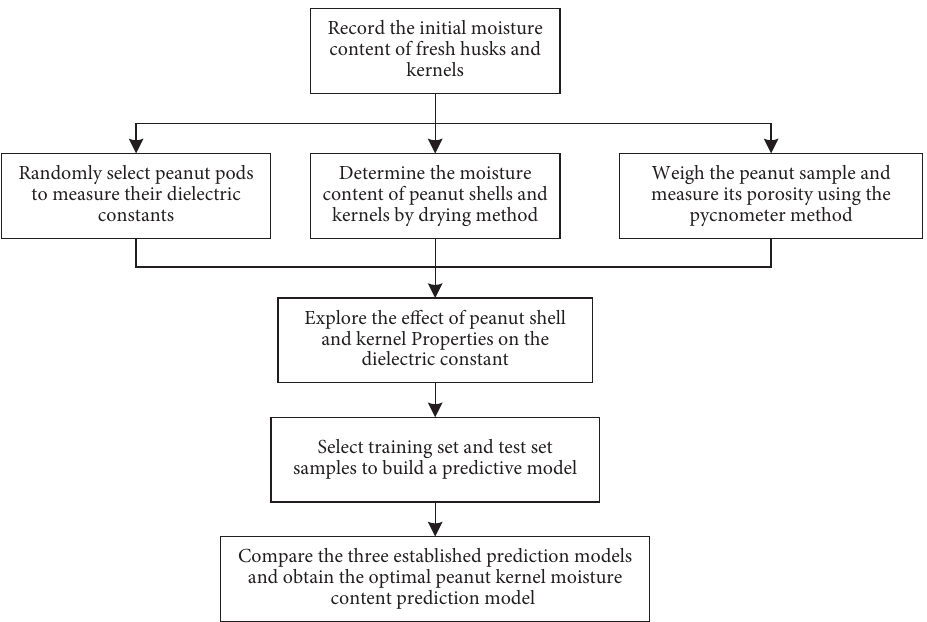
Figure 3: Predictive modeling